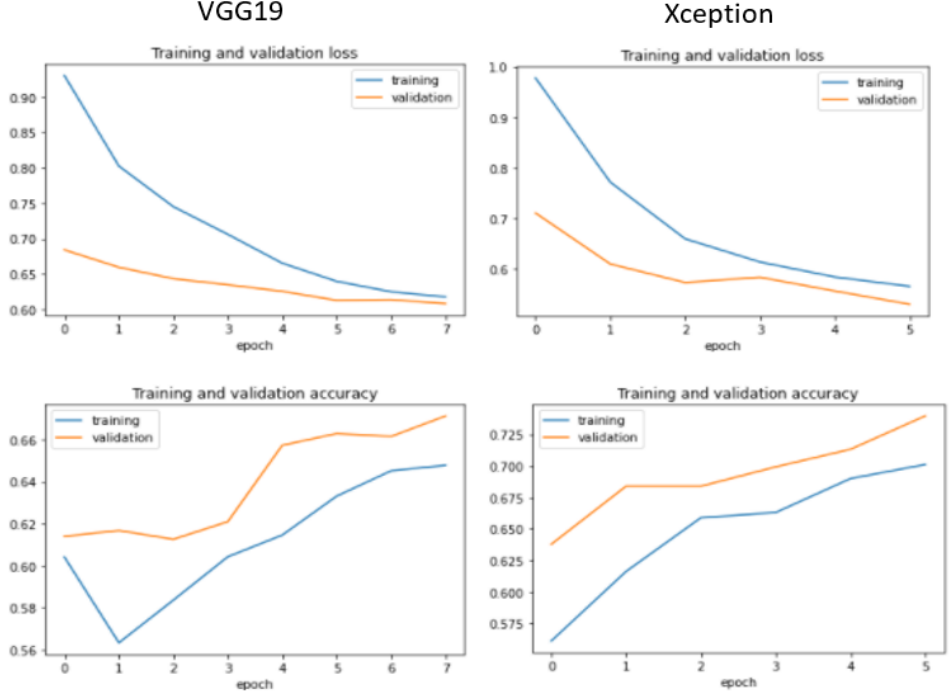
Figure 9. Training and validation performance for VGG19 and